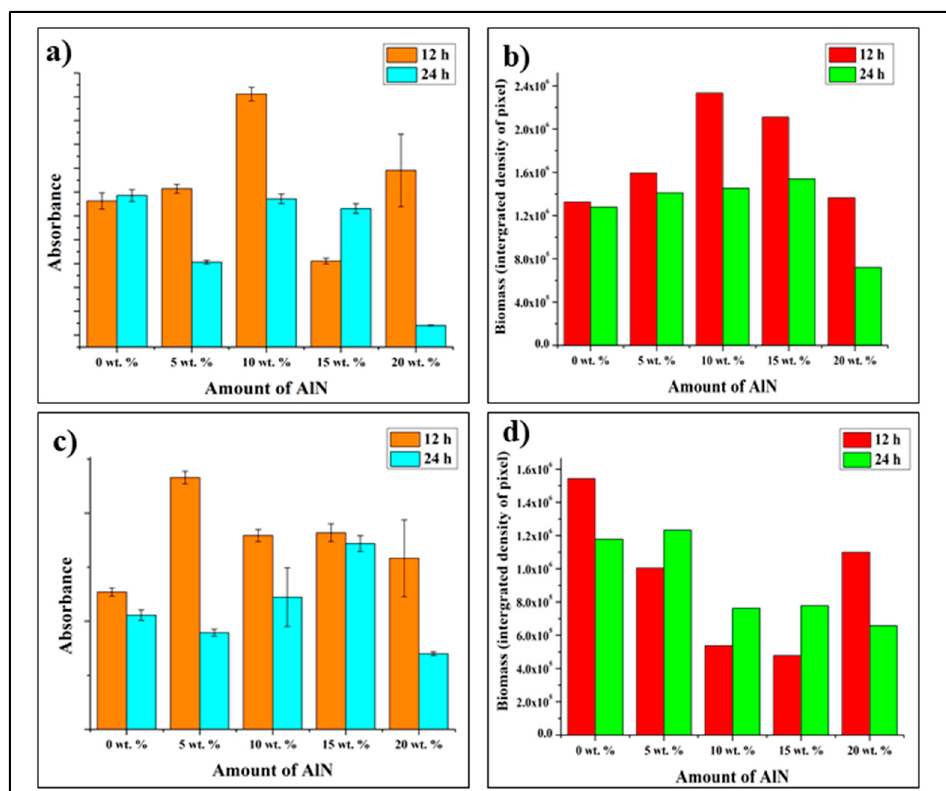
Figure 11. ( a ) Staphylococcus epidermidis biofilm formation after 12 and 24 h evaluated by quantitative measurement of crystal violet staining as an indicator of biomass accumulation on CA/AlN composites, ( b ) Quantitative comparison of accumulated biomass in ( a ), ( c ) Escherichia coli biofilm formation after 12 and 24 h evaluated by quantitative measurement of crystal violet staining as an indicator of biomass accumulation on CA/AlN composites, ( d ) Quantitative comparison of accumulated biomass in ( c ).